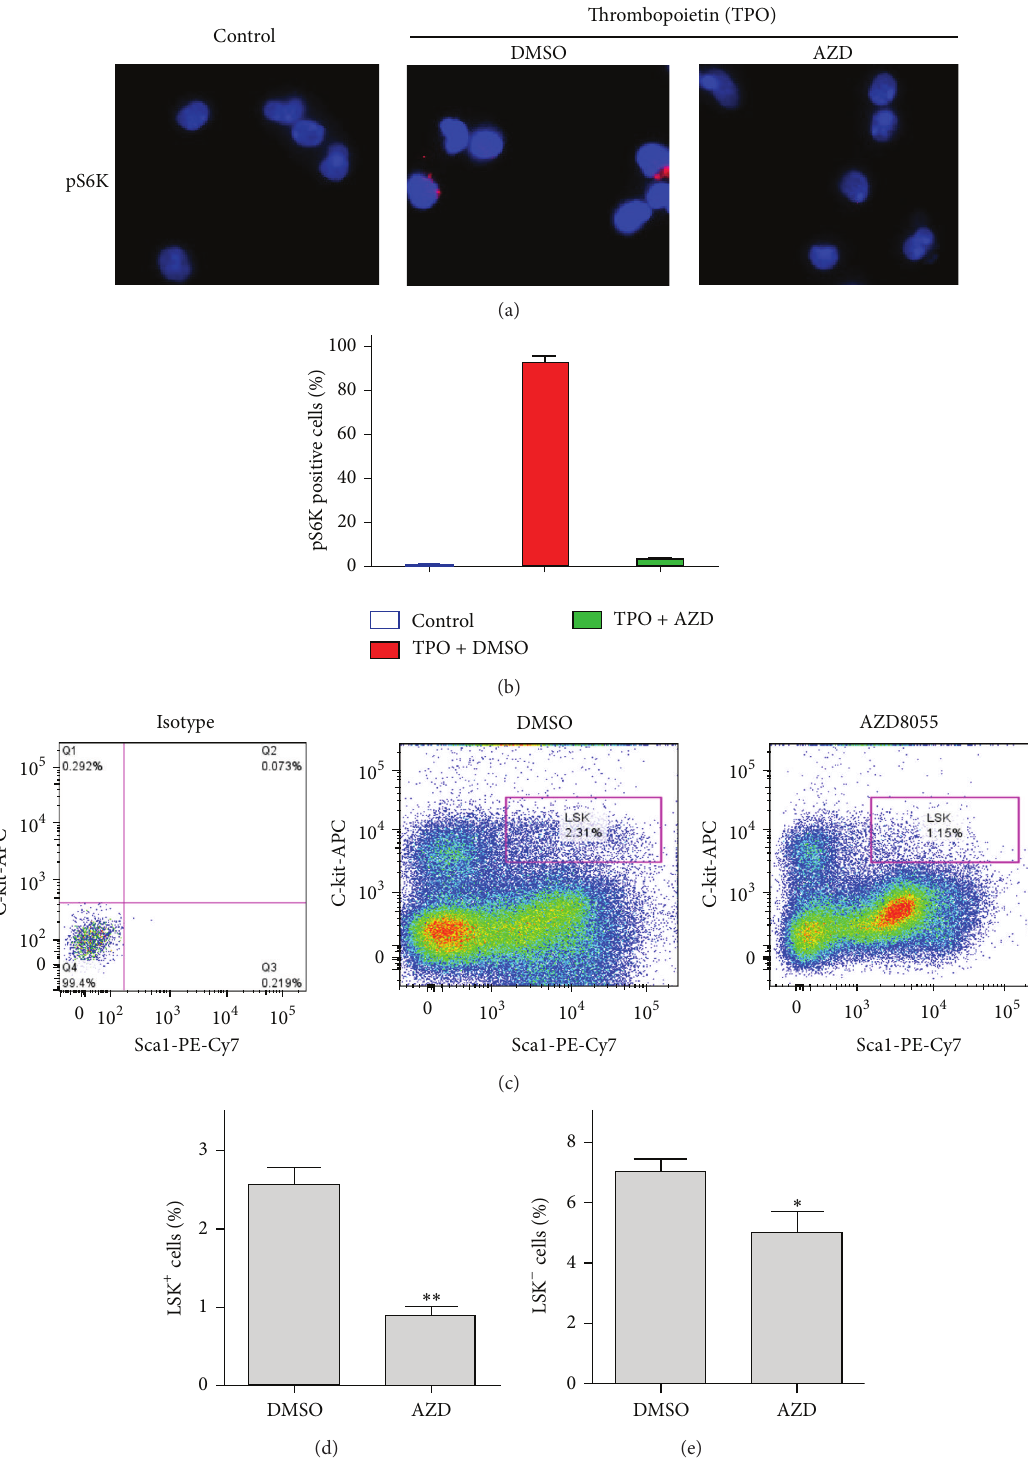
Figure 1: Inhibition of mTOR depletes HSPCs in culture. (a) Phosphorylated S6K (pS6K) was determined using a pS6K specific monoclonal antibody and immunofluorescence microscopy. (b) The percentage of pS6K positive cells was calculated and is presented as mean +/ − SEM. (c) The frequency of Lin − Sca-1 + c-Kit + (LSK + ) cells (HSCs/MPPs enriched subpopulations) and Lin − Sca-1 − c-Kit + (LSK − ) cells (HPCs) in cultures after AZD treatment was determined by flow cytometric analyses and representative flow cytometric graphs are presented. (d) The frequency of LSK + cells in cultured mouse BM Lin − cells at 20 h after AZD treatment is presented as mean +/ − SEM. (e) The frequency of HPCs in in cultured mouse BM Lin − cells at 20h after AZD treatment is presented. Data are presented as mean +/ − SEM of three independent experiments. ∗ 𝑝 < 0.05 ; ∗∗ 𝑝 < 0.01 versus DMSO vehicle